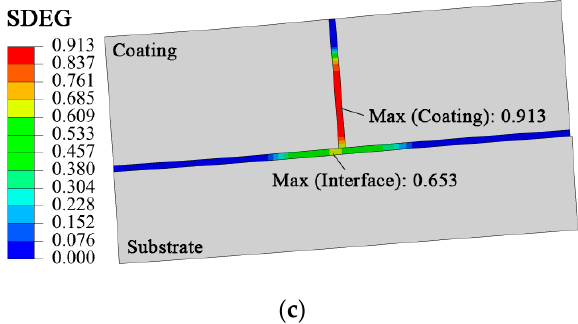
Figure 11. Evolution of coating crack and interfacial delamination in the coating–substrate system for ( a ) damaged coating and perfect interface, ( b ) perfect coating and damaged interface, and ( c ) damaged coating and interface.